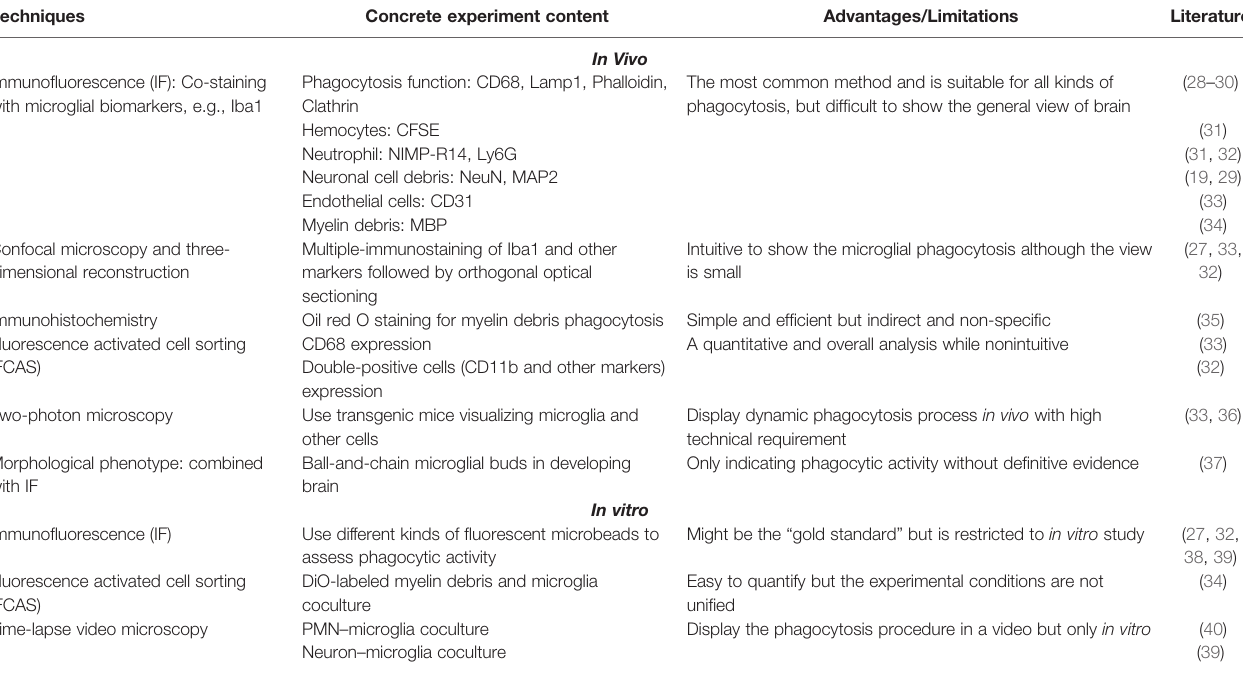
TABLE 1 | Different techniques available to assess microglial